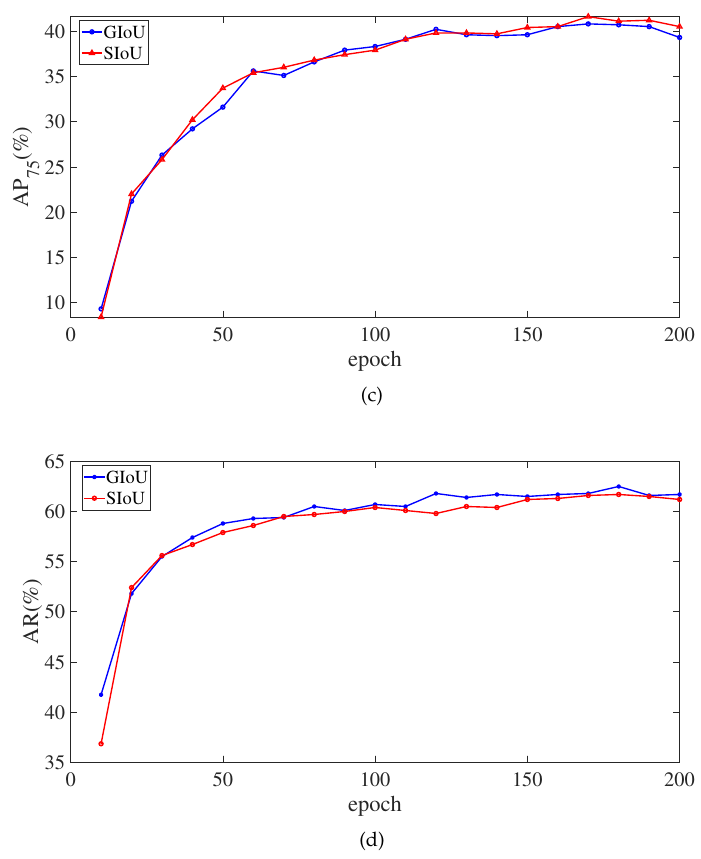
Figure 9. The AP and AR value changes during training. ( a ) The change curves of the AP value. ( b ) The change curves of the AP 50 value. ( c ) The change curves of the AP 75 value. ( d ) The change curves of the AR